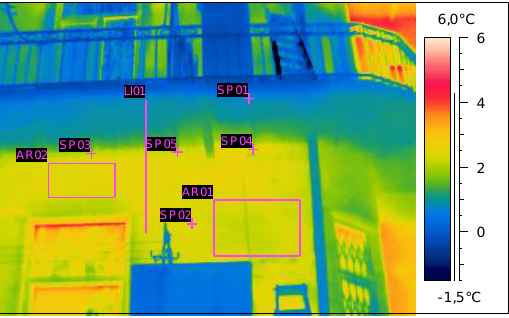
Figure 9. Frontal facade thermovision diagnostics with measurements.